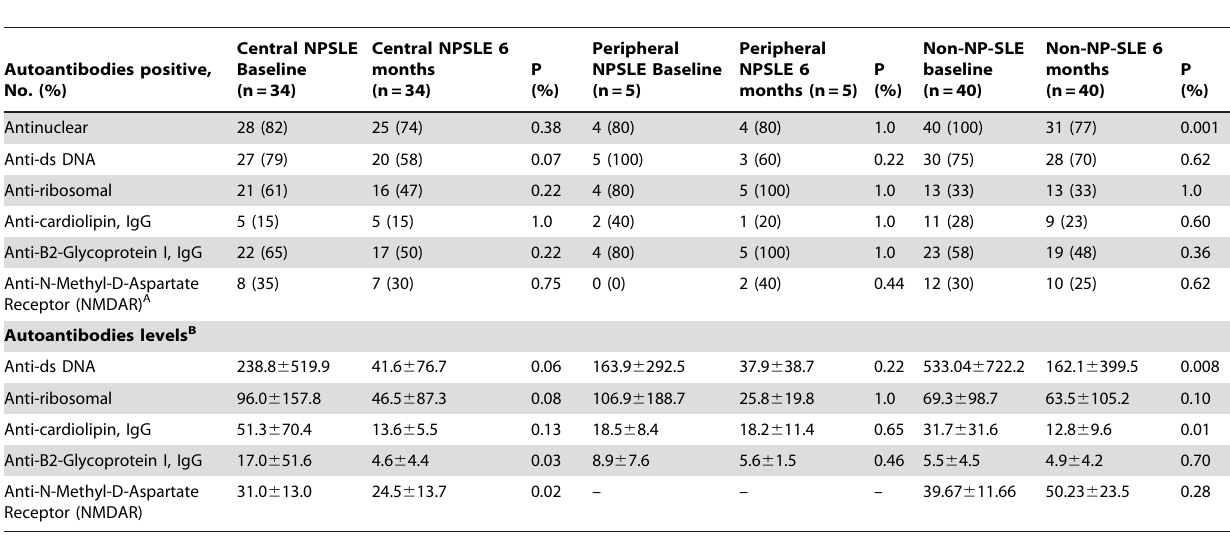
Table 3. Prevalence and levels of autoantibodies in serum of patients with central and peripheral NPSLE, and non-NPSLE at baseline and 6